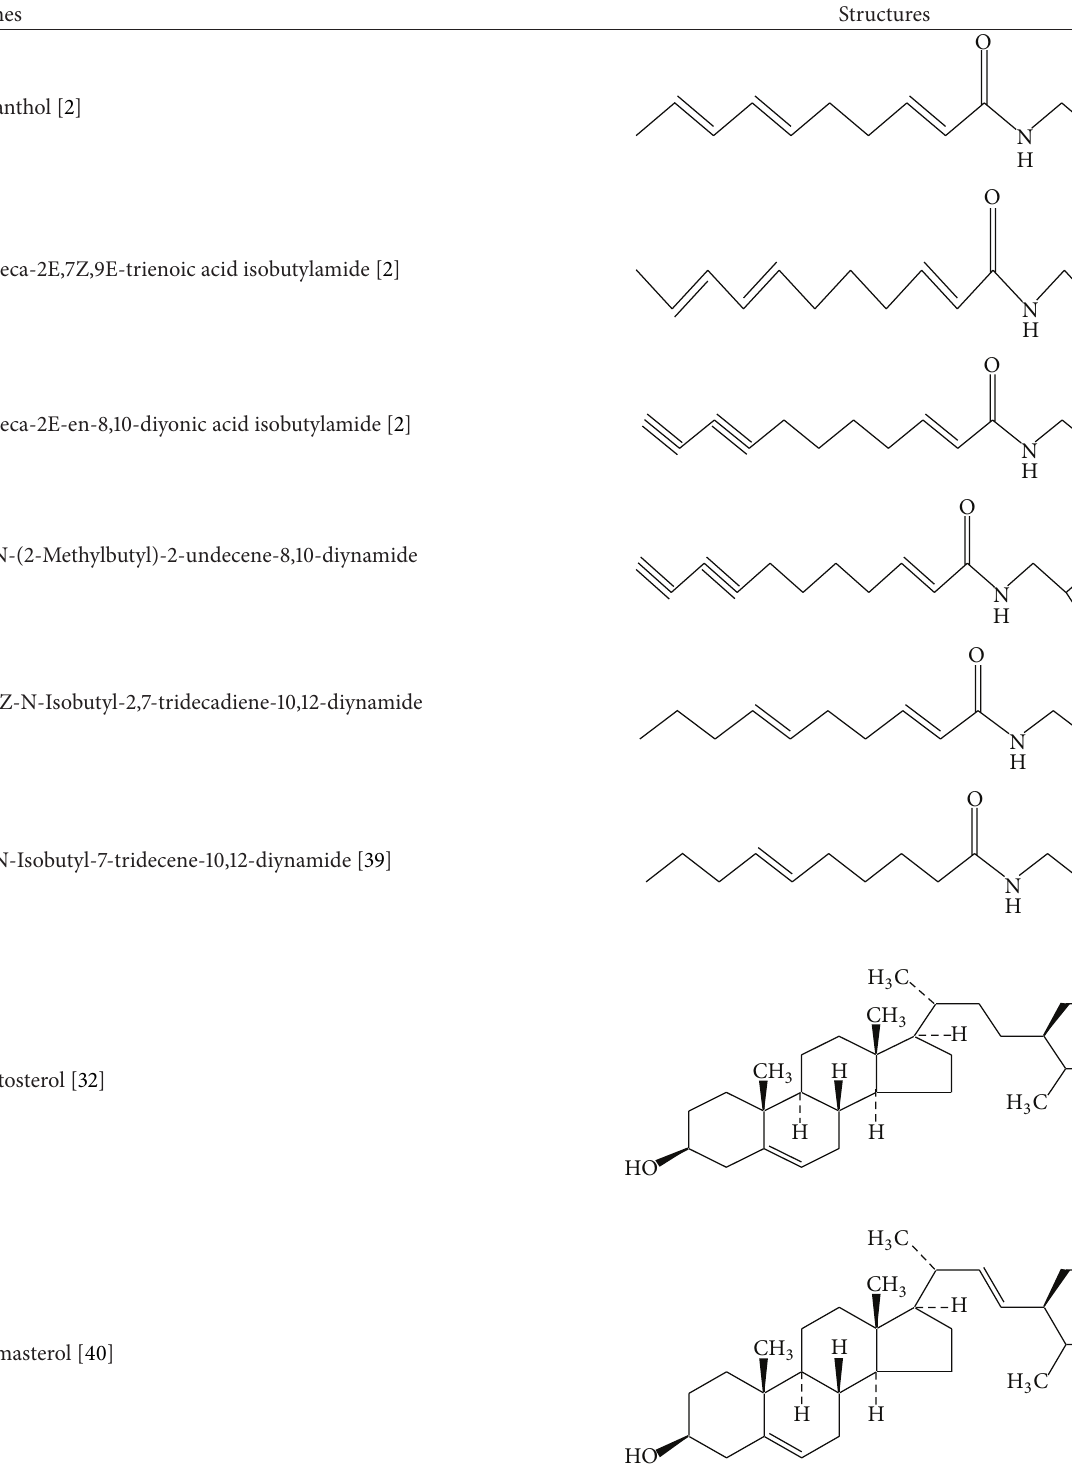
Table 1: Chemical structures of secondary metabolites of Spilanthes acmella